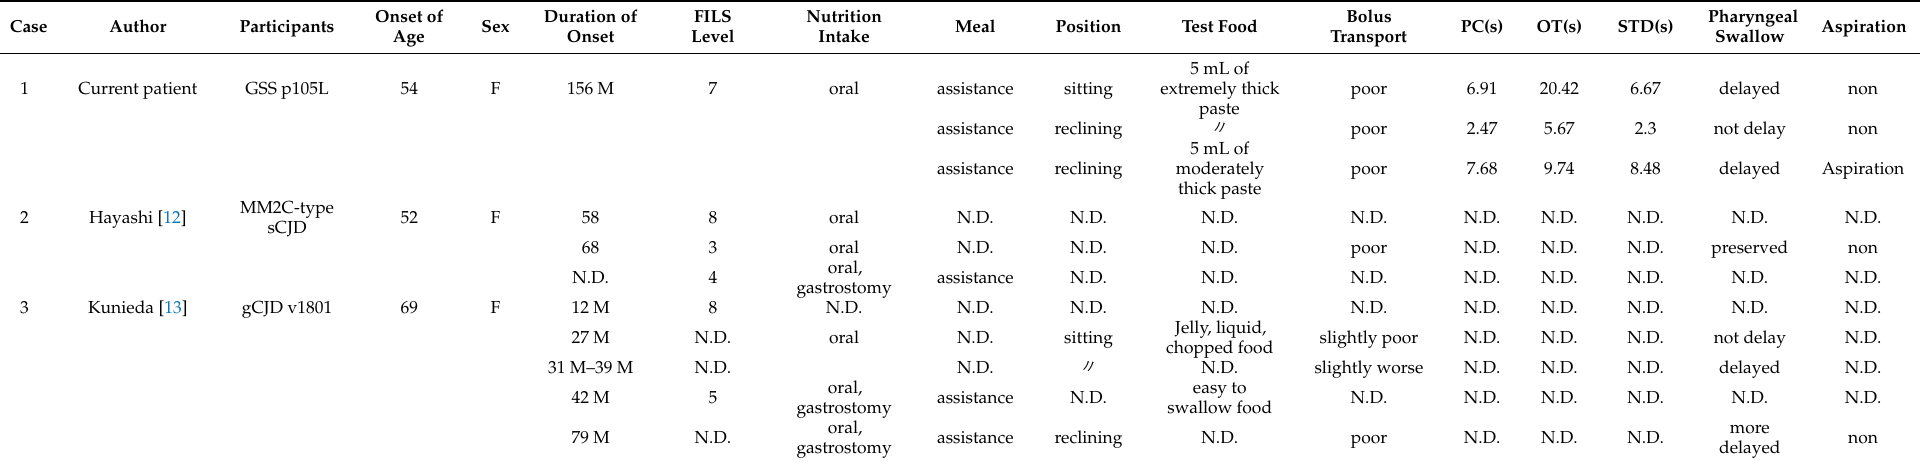
Table 2. The results of swallowing function assessments of patients with prion disease.